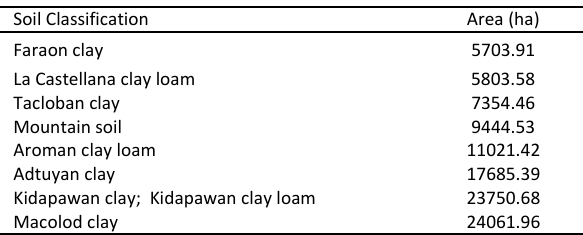
Fig. 2: Delineated Subwatersheds of Table 2: Soil type of Muleta watershed Table 2: Soil type of Muleta watershed